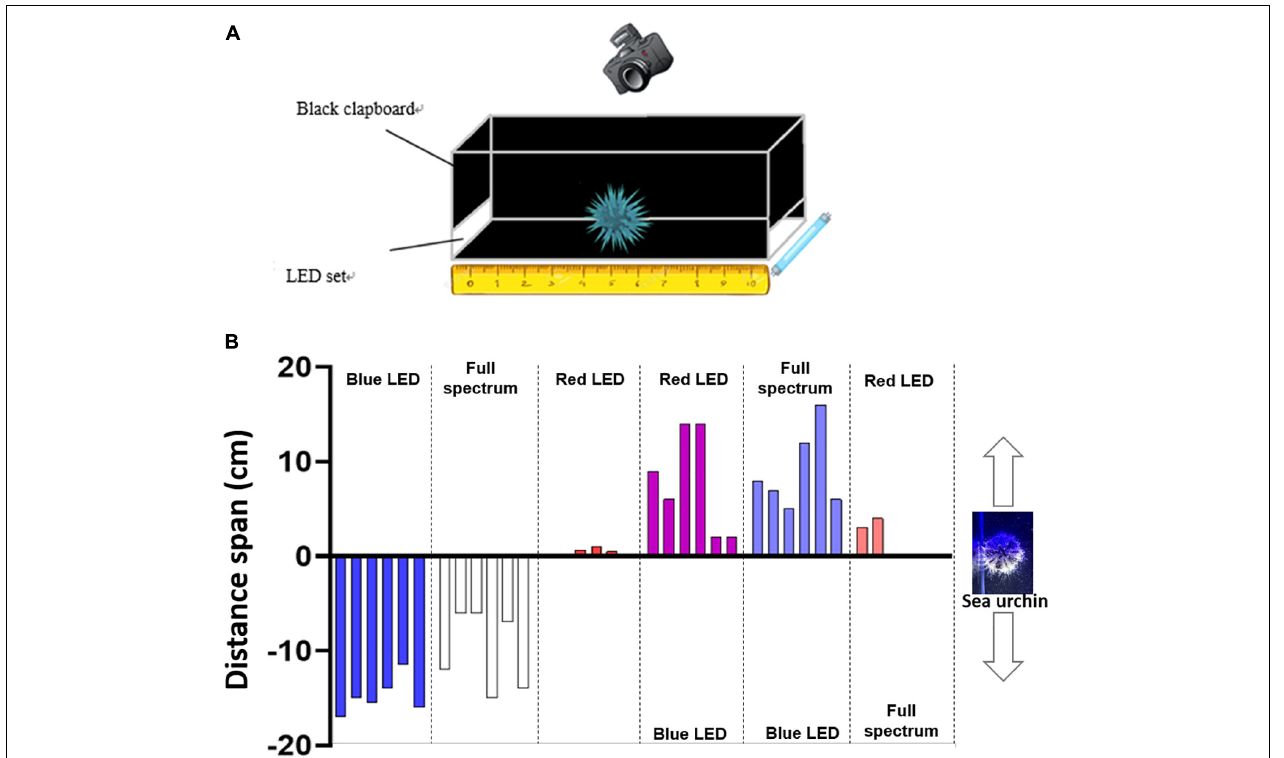
FIGURE 7 | The phototaxis of T. gratilla . (A) Schematic diagram of the tank and LED light sources used in phototaxis experiment. (B) Measured distance span for each sea urchin tested in different light conditions. Measured distances were taken as positive (+) or negative (–) depending upon whether the sea urchin was moving toward or away from the light